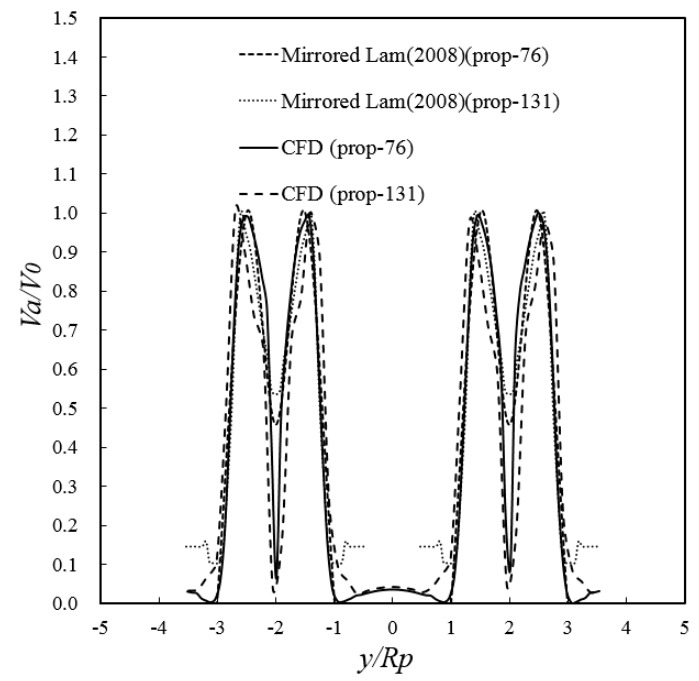
Figure 7. Axial velocity distributions at the efflux plane. Table 4. Positions of maximum efflux velocity.